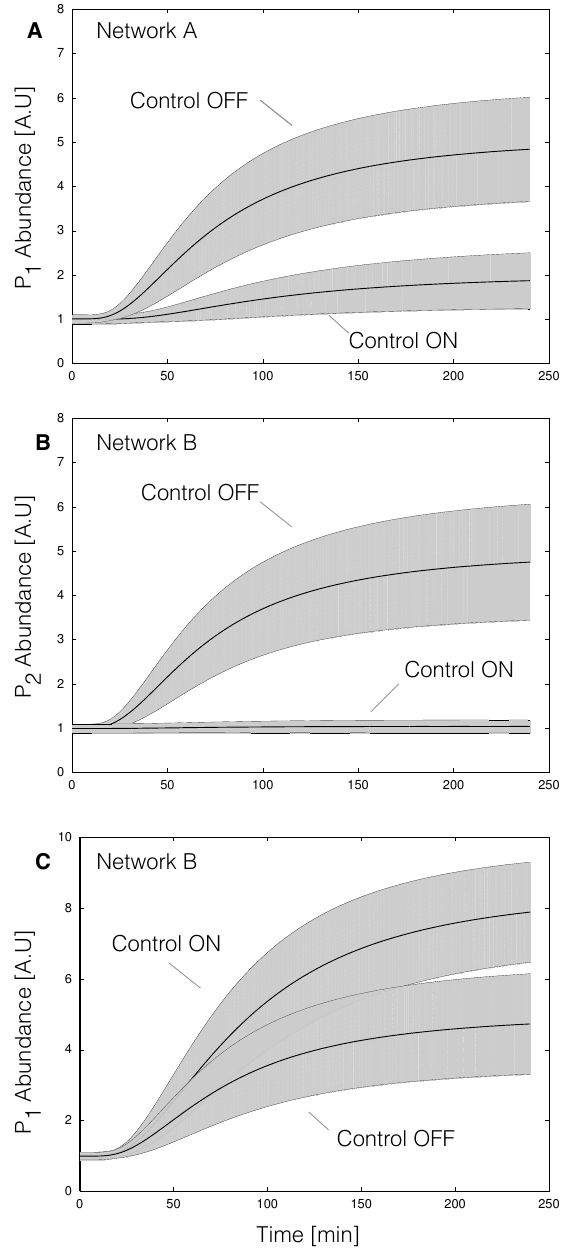
Figure 4. ON/OFF control simulations for Network A and Network B for an ensemble of 100 kinetic parameter sets versus time. For each case, simulations were conducted using kinetic and initial conditions generated randomly from a hypothetical true parameter set. The gray area represents one standard deviation surrounding the mean. Control parameters ± were fixed during the ensemble calculations. ( A ) End product P abundance versus time 1 for Network A. The abundance of P decreased with end product inhibition of E activity 1 1 (Control-ON) versus the no inhibition case (Control-OFF); ( B ) End product P abundance 2 versus time for Network B. Inhibition of branch point E by end product P decreased P 6 1 2 abundance (Control-ON) versus the no inhibition case (Control-OFF); ( C ) End product P 1 abundance versus time for Network A. Inhibition of branch point E by end product P 6 1 decreased P abundance (Control-ON) versus the no inhibition case 1